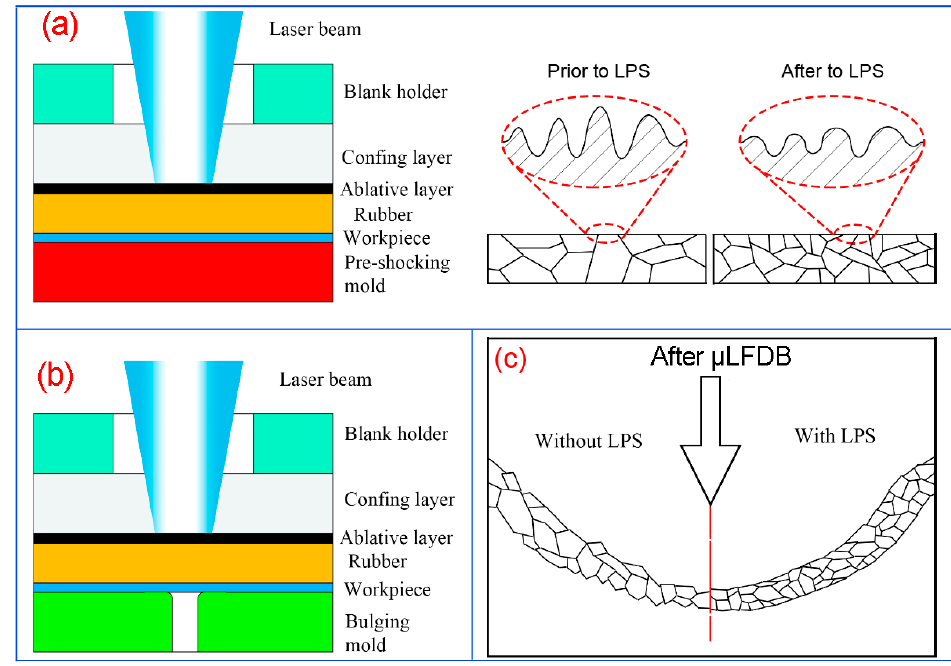
Figure 1. Schematic of microscale laser dynamic flexible bulging ( µ LDFB). ( a ) LPS; ( b ) µ LDFB; ( c ) effect of LPS on the bulging